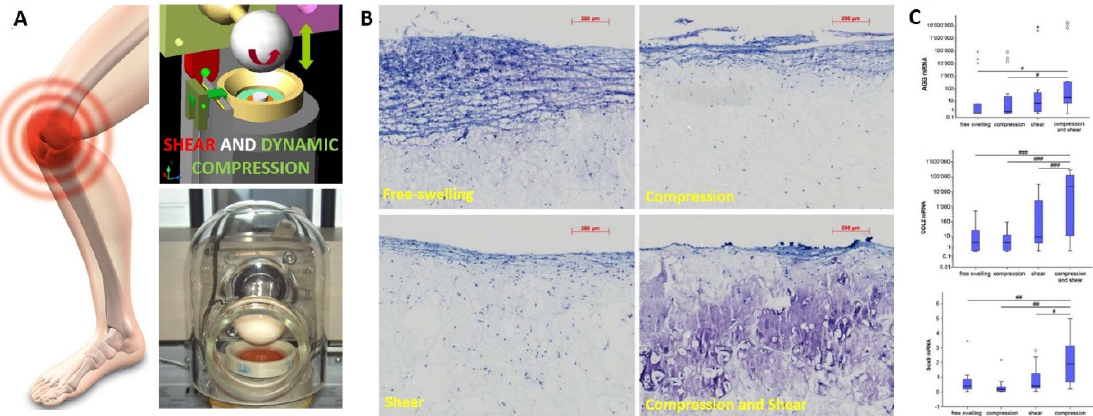
Figure 8. Shear and dynamic compression are critical component to achieve successful mechanical loading induced-chondrogenesis in human mesenchymal stem cells. This finding can be useful to develop better rehabilitation protocols for MSCs-mediated cartilage repair. Joint-simulation bioreactor capable to apply multiaxial loading miming knee joint motions ( A ). Shear in combination with compression is crucial for the enhanced deposition of proteoglycan-rich extra-cellular matrix as showed in toluidine blue staining ( B ) and for the upregulation of the cartilage gene expression markers Sox9, COL2 and Aggrecan. ( C ) Relative mRNA expression of human mesenchymal stem cells after 21 days, * and ◦ depict outlier samples. # p < 0.05, ## p < 0.01, ### p < 0.001. Images modified from with permission Schatti at al., 2011 [295].